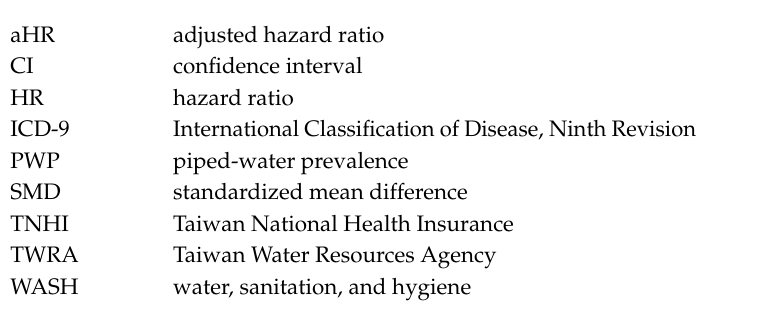
disease identification, Table S3: Baseline characteristics in the study and alternative control cohorts—sensitivity analysis, Table S4: Comparing the incidence and HR of appendicitis between the study and alternative control Table S6: Average water quality in Taiwan during 2002–2011; STROBE